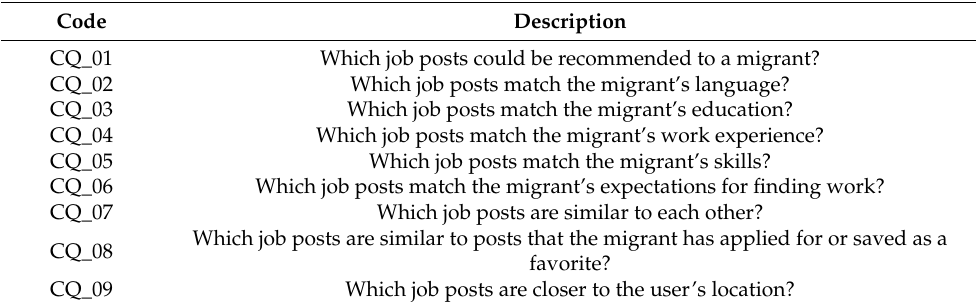
Table 3. Competency Questions relevant to Semantic Reasoning.